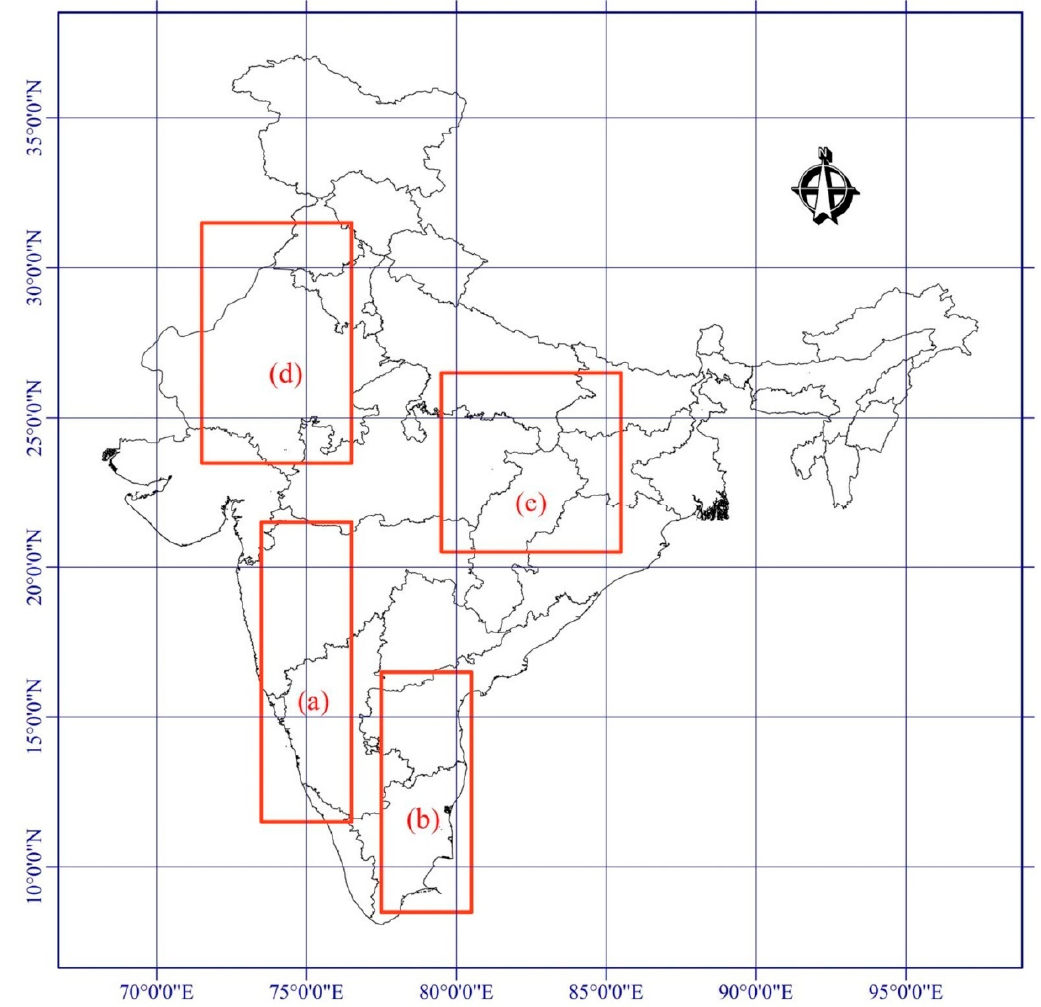
Figure 1. Study area and geographical subregions chosen for the study. The subregions are: subregion a, southwest (11.5°N–21.5°N, 73.5°E–76.5°E); subregion b, southeast (8.5°N–16.5°N, 77.5°E–80.5°E); subregion c, central (20.5°N–26.5°N, 79.5°E–85.5°E); and subregion d, northwest(23.5°N–31.5°N,71.5°E–76.5°E).